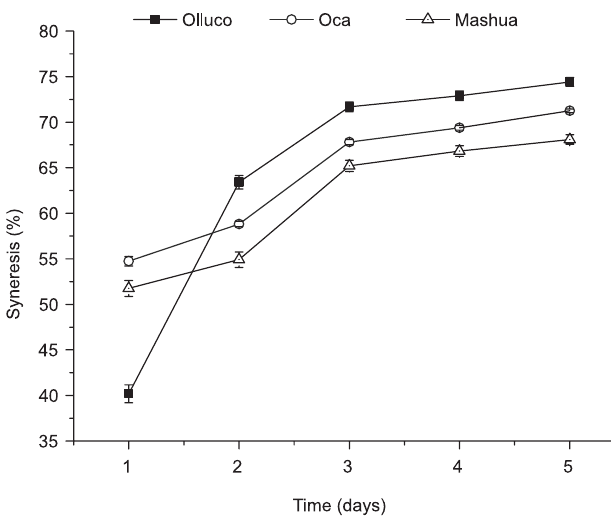
FIGURE 4 - Effect of storage on the paste stability of oca, olluco and mashua